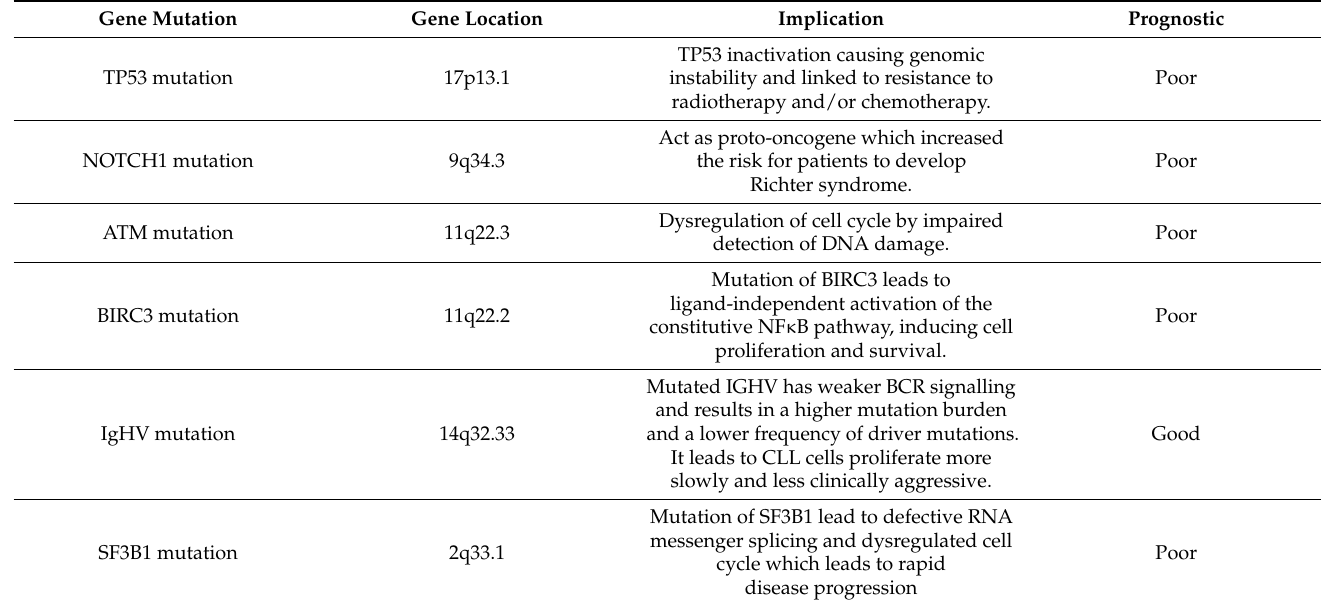
Table 3. Predictive biomarkers influence prognosis in